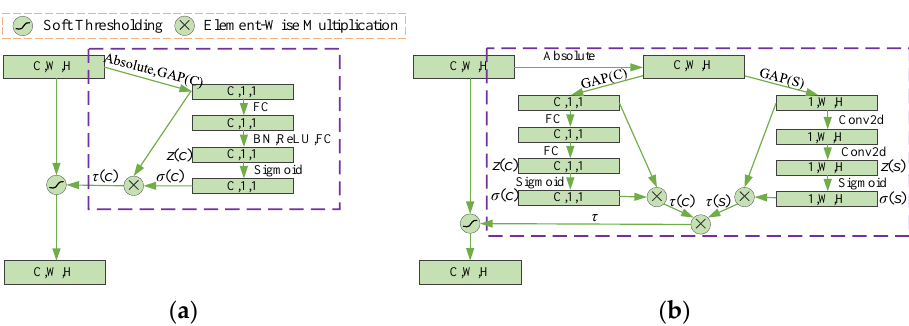
Figure 1. Structure of channel threshold acquisition network (C-TAN) and channel spatial threshold acquisition network (CS-TAN). ( a ) Structure of C-TAN; ( b ) Structure of CS-TAN. Finally, σ ( c ) and 1-D vector are multiplied to get the thresholding containing the channel information of the feature map X , as shown in Equation (3).